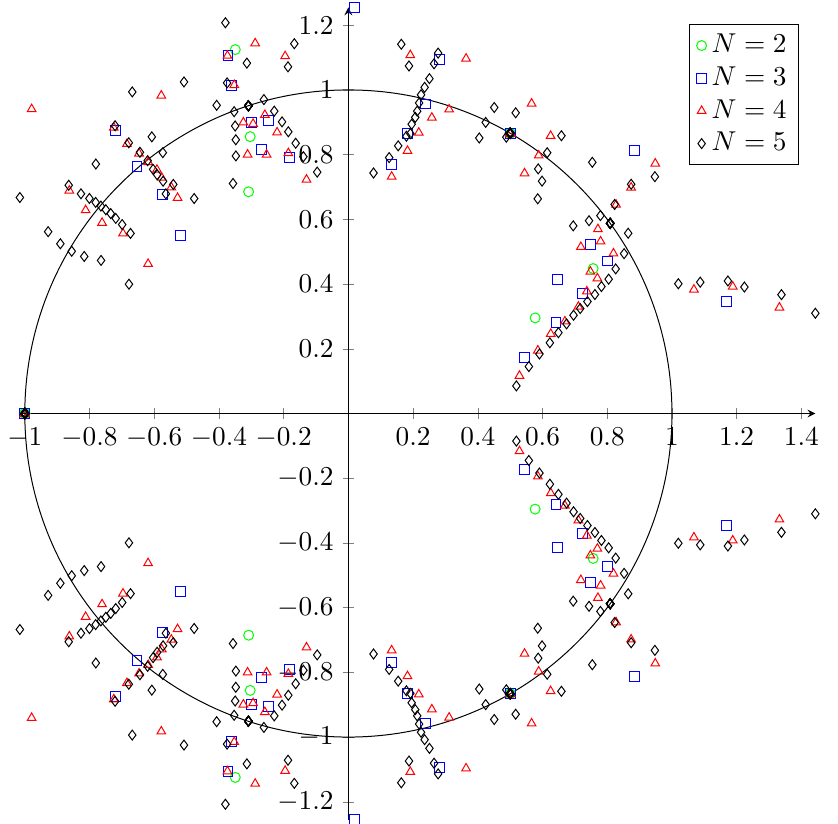
Figure 3 . Zeros of the free partition functions in the su (2 j 3) sector for N = 2 : : : 5 plotted in the complex plane of a = e (cid:0) 1 2 T . The right-most zeros appear to ‘condense’ in two arcs pinching the real axis just around the Hagedorn temperature a su (2 j 3) ; tree = 1 = 2 of the in(cid:12)nite- N theory. This H hints at a phase transition of Lee-Yang